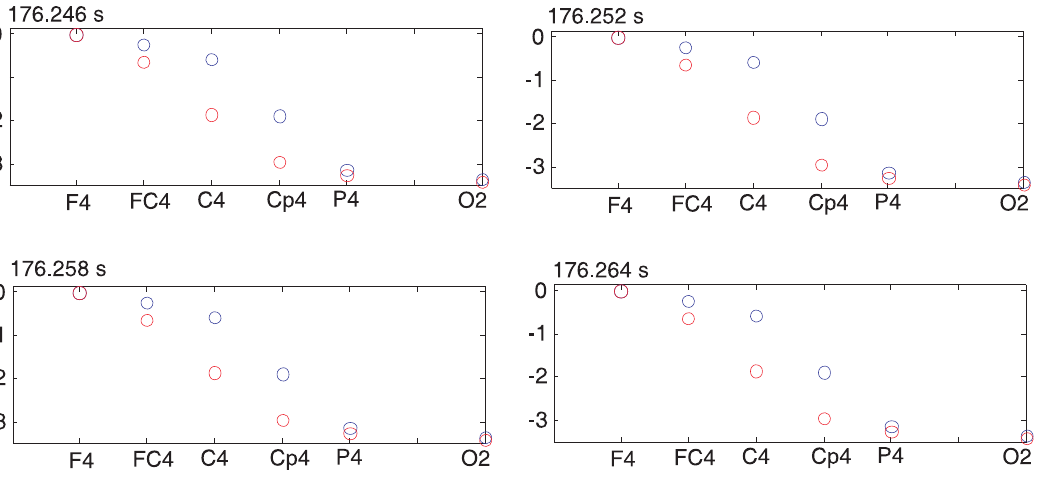
Figure 5. Phase differences along the chain of electrodes, including F4, FC4, C4, CP4, P4, and O2, at different times with step size of 6 ms. Red circles are the calculated phases for EEG signals with the average mastoid reference, black ones for EEG signals with an average reference; this result indicates that these phase differences do not sensitively depend on the reference channel.